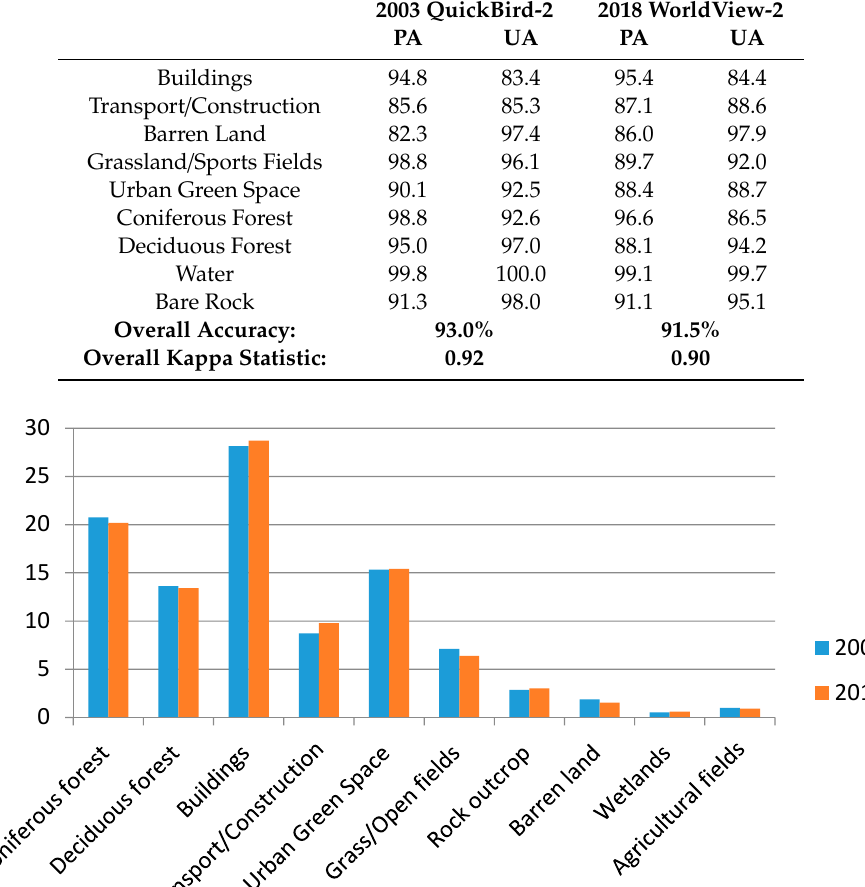
Table 2. Class and overall accuracies for the 2003 and 2018 classifications (PA = producer’s accuracy, UA = user’s accuracy).